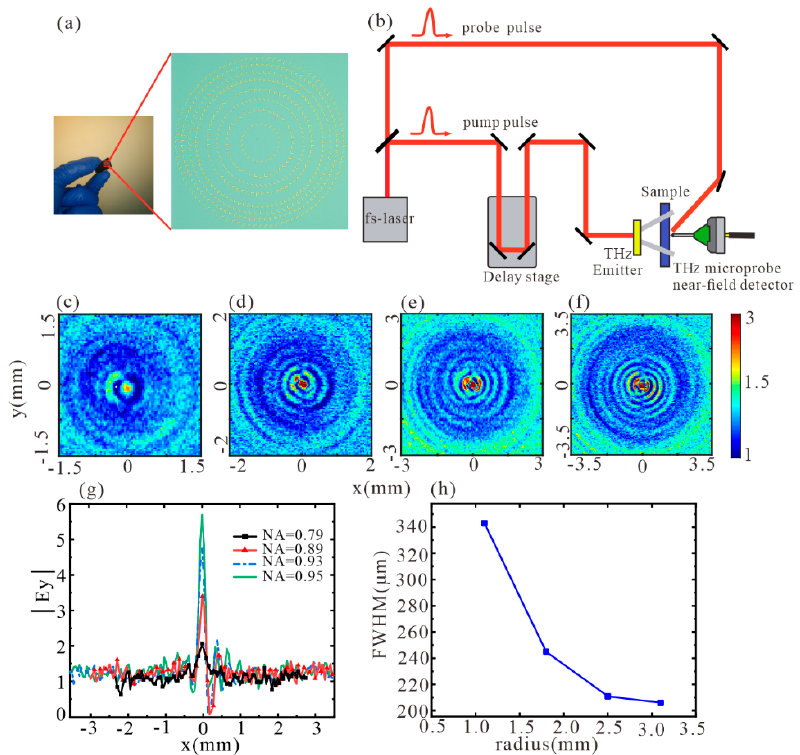
Figure 4. ( a ) Microscope image of fabricated metalens sample. ( b ) Schematic of the THz near-field imaging system. ( c – f ) Experimentally obtained electric field distributions of metalens with NA = 0.79, 0.89, 0.93, and 0.95, corresponding to r = 1135 μ m, 1877 μ m, 2515 μ m, and 3131 μ m, respectively. ( g ) The electric field distributions along the x axis at the focal plane. ( h ) The relationship between FWHMs and r.